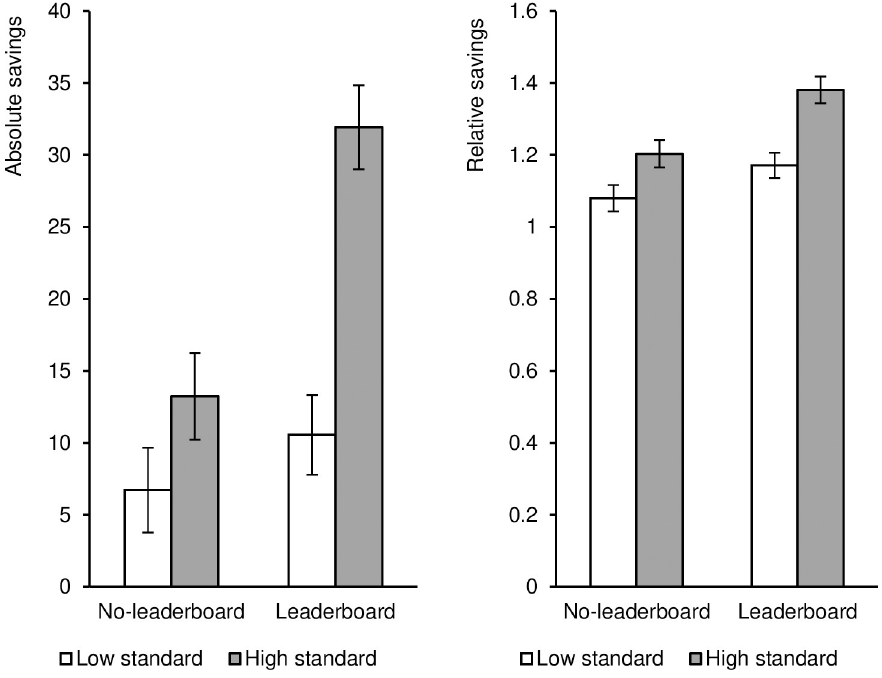
Fig 1. Absolute savings (left panel) and relative savings (right panel) as a function of the leaderboard and the standard of upward comparison (low vs. high). (Error bars indicate +/–1 Standard Error of the Mean).